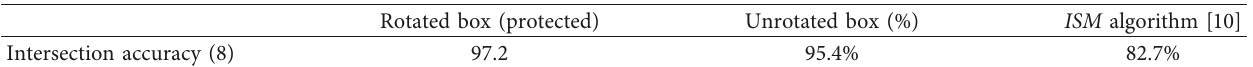
Figure 13: Branch road detection results and intersection navigating results using motion-planning algorithms; (a) map1 (Figure 10(a)), (b) map2 (Figure 10(b)), and (c) map3 (Figure 10(c)) and (d) case with obstacles existing in branch road Table 2: Intersection detection results.